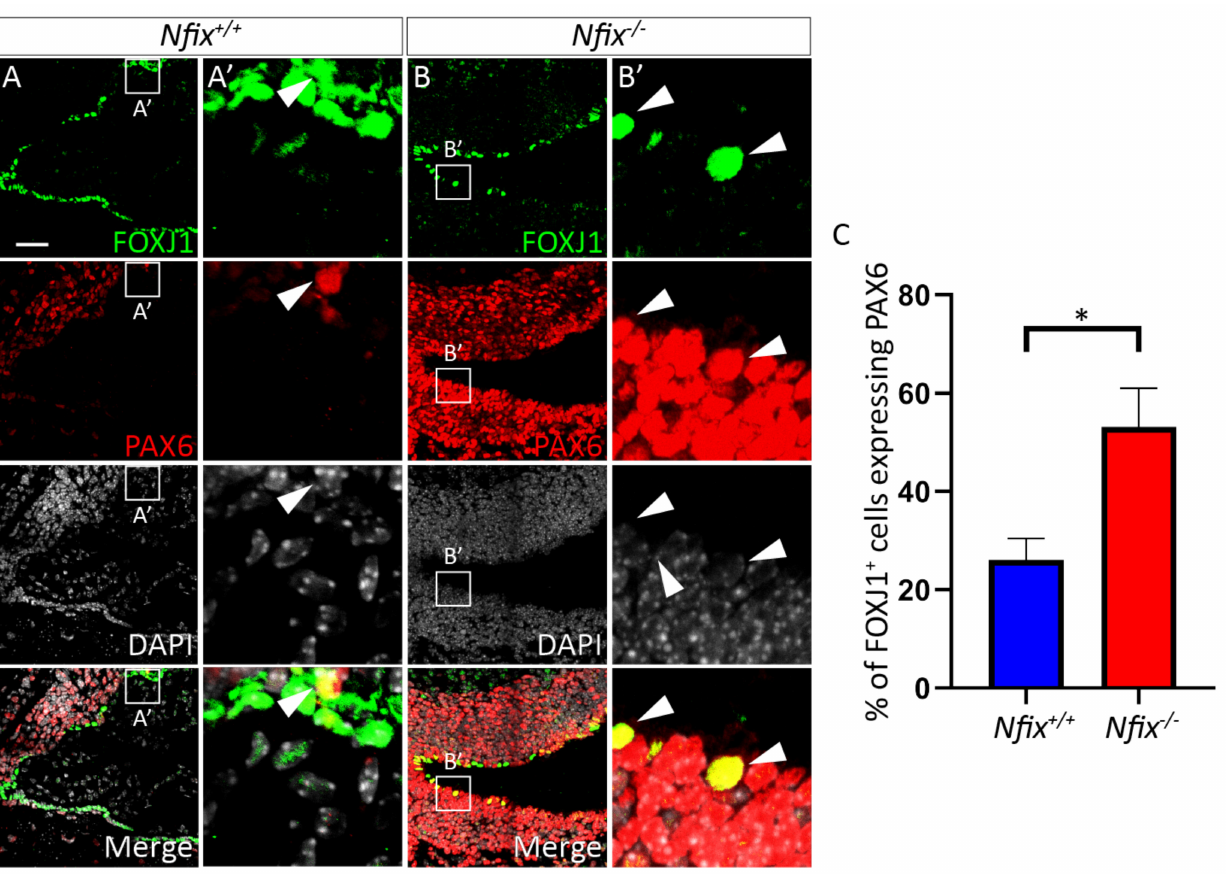
Figure 4. P5 Nfix − / − ependymal cells have increased expression of PAX6. ( A , B ) Images of lateral ventricles from P5 Nfix +/+ ( A ) and Nfix − / − ( B ) mice stained with antibodies against ependymal cell marker FOXJ1 (green), radial glial cell marker PAX6 (red) and nuclear marker DAPI (grey), displayed separately and merged. ( A’ , B’ ) Enlarged images of regions depicted in white boxes A’ and B’ are shown in panels ( A’ , B’ ). White arrowheads depict FOXJ1 + /PAX6 + cells. ( C ) Panel displays the proportion of FOXJ1 + ependymal cells also expressing PAX6 in Nfix − / − mice and controls. A significantly higher proportion of P5 FOXJ1 + Nfix − / − ependymal cells displayed PAX6 expression compared to controls. * p < 0.05, two-tailed t -test. Graphs depict mean ± s.e.m. from three samples per genotype, 50 nuclei per sample. Scale bar ( A ) represents 50 µ